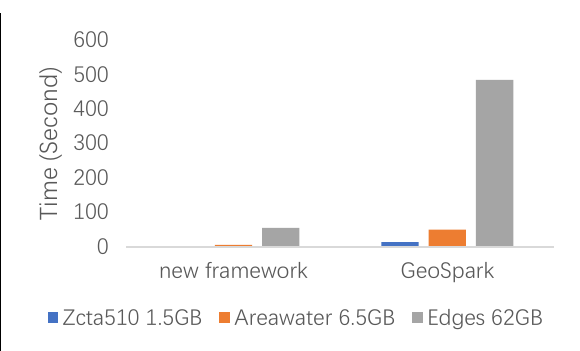
Figure 6. Spatial join experiments with different frameworks and data